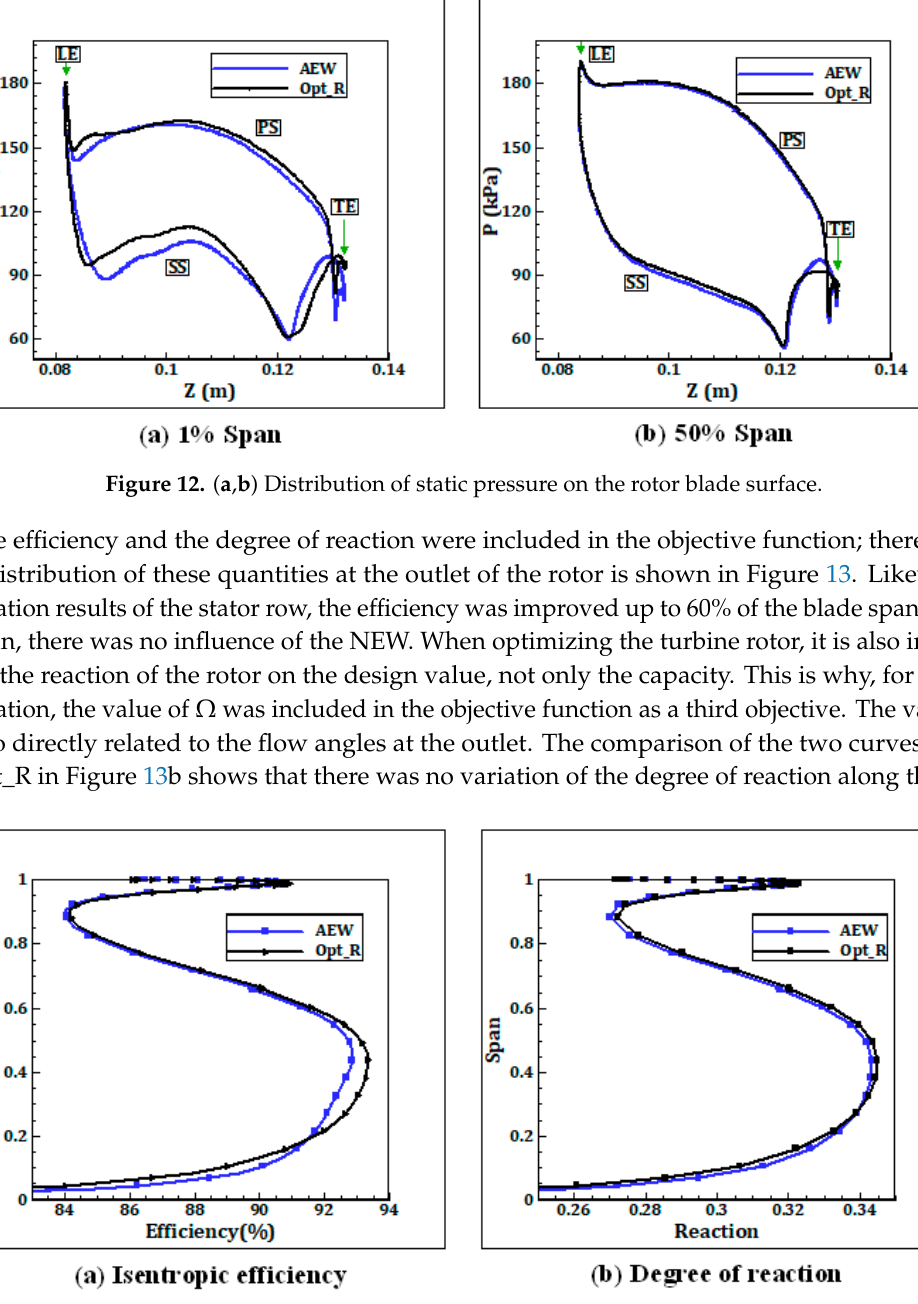
Figure 13. ( a , b ) Spanwise distribution of mass-averaged Figure 13. ( a,b ) Spanwise distribution of mass-averaged quantities.